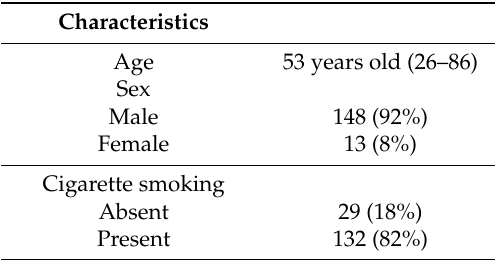
Table 1. Clinicopathological parameters in 161 patients with oral tongue squamous cell carcinoma receiving surgical